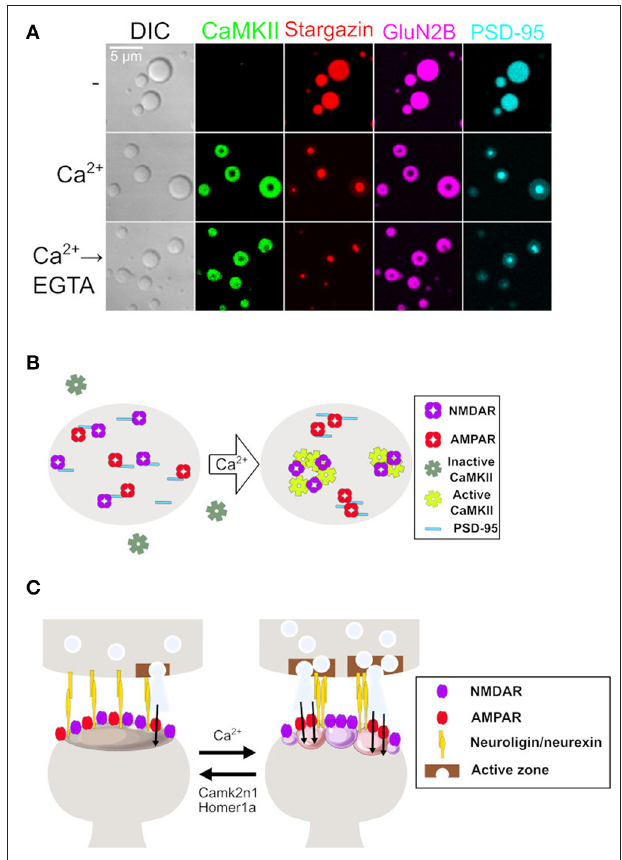
FIGURE 1 | LLPS to synaptic plasticity. (A) Microscope images of protein condensates consist of the following four proteins during calcium stimulation. From left to right, confocal images of differential interference contrast and confocal fluorescent images of CaMKII, Stargazin, GluN2B, and PSD-95. Stargazin, GluN2B, and PSD-95 are homogenously distributed before Ca 2 + . Ca 2 + triggers the incorporation of CaMKII and the formation of a